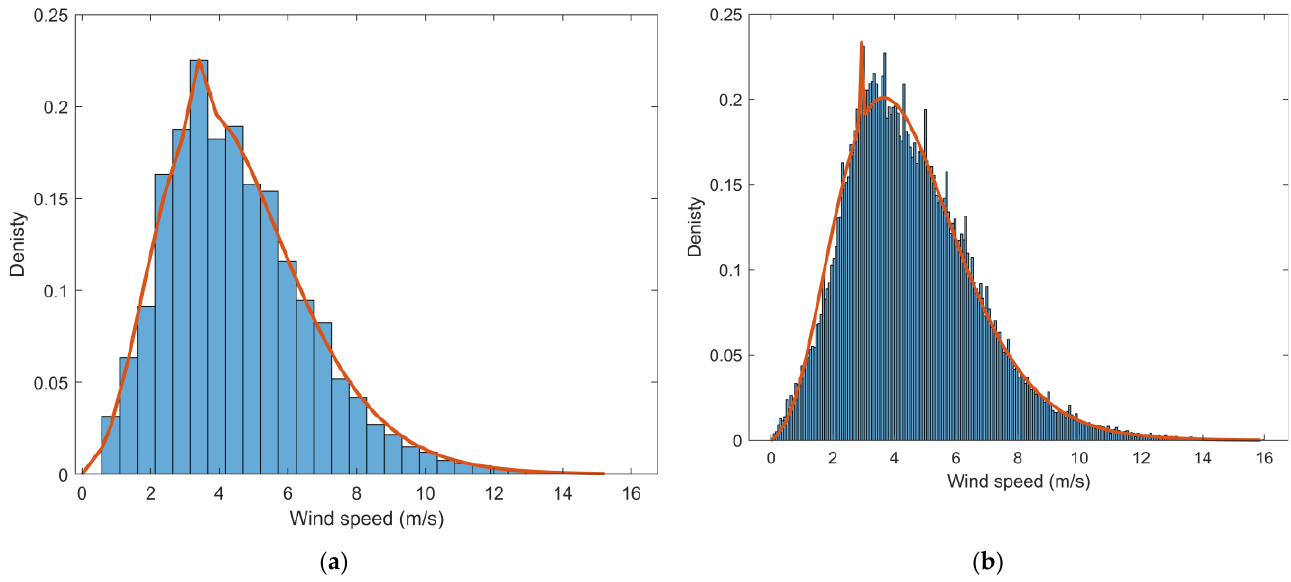
Figure 3. Fitting wind data of Site 1 to 𝑓 𝑚𝑖𝑥 using MOPSO: ( a ) 30 equal wind speed spacings; ( b ) variable wind speed spacings.